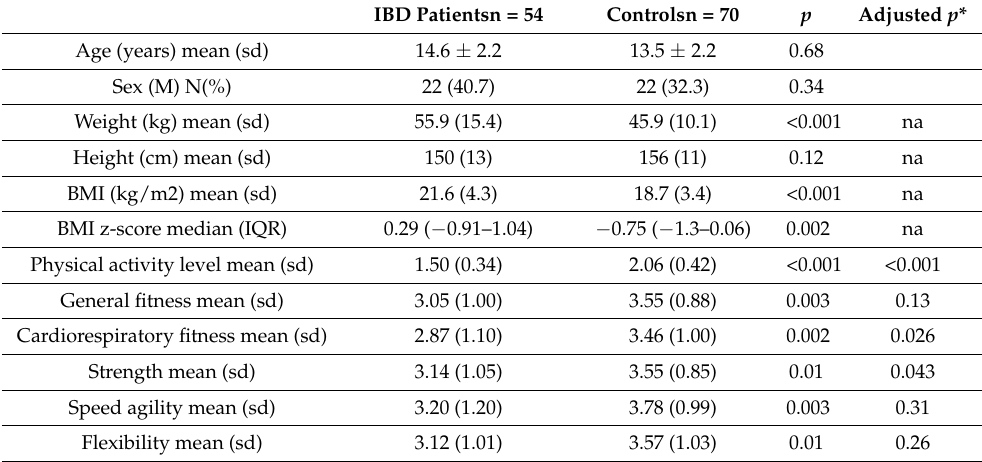
Table 1. Clinical features, physical activity level, and fitness performance of patients with inflamma- tory bowel disease (IBD) and